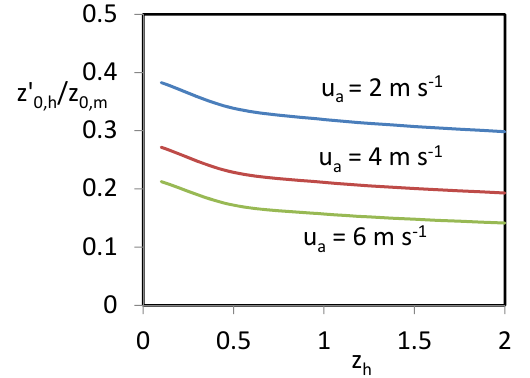
Figure 4. Variation of the ratio between the modified roughness ) and the roughness length for momentum ( z 0, m ) as a length ( z (cid:48) 0, h function of crop height ( z h ) for different wind speeds at the refer- ence height ( u a ) and LAI = 3. Table 2. For three types of climate (SA, SH, H ) and three differ- ent temperatures, relative error made on the value of foliage sur- face resistance ( r s, f ) , as inferred from the basal crop coefficient ( K cb ) , when calculated with the simplified formula (Eq. 25) com- pared to the comprehensive formula (Eq. 23). K cb = 0.9, K e = 0.1,